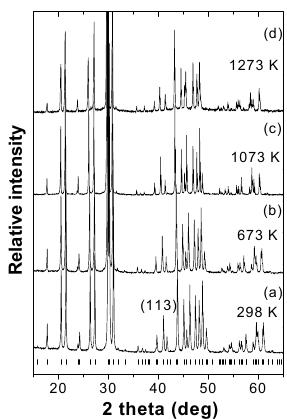
Figure 1. Selected X-ray diffraction (XRD) patterns of pyromorphite at varied temperatures. ( a ) XRD pattern collected at room temperature (298 K). The bottom ticks are the positions of the reflections. 113 reflection is highlighted to monitor the shift of the pattern at high temperature. ( b – d ) XRD patterns collected at 673, 1073 and 1273 K respectively, which show a shift to the lower angle. The background of the XRD pattern is rising at 1273 K.